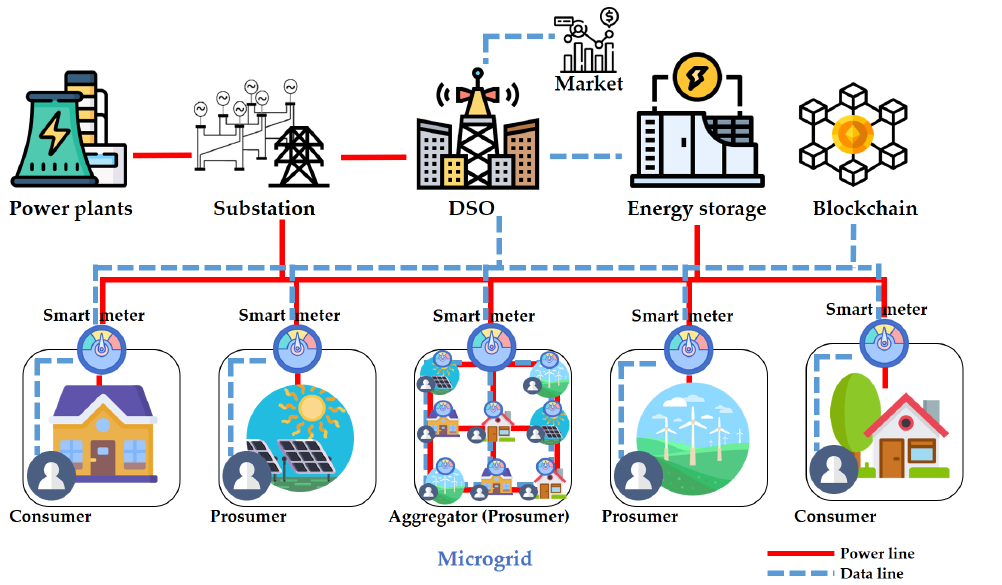
Figure 4. Proposed energy trading system